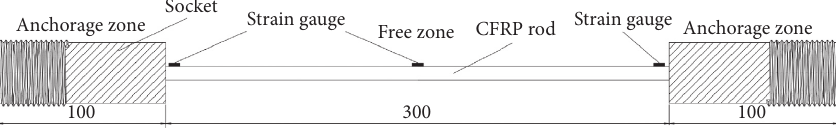
Figure 11: Dimension of the specimen (unit: mm).